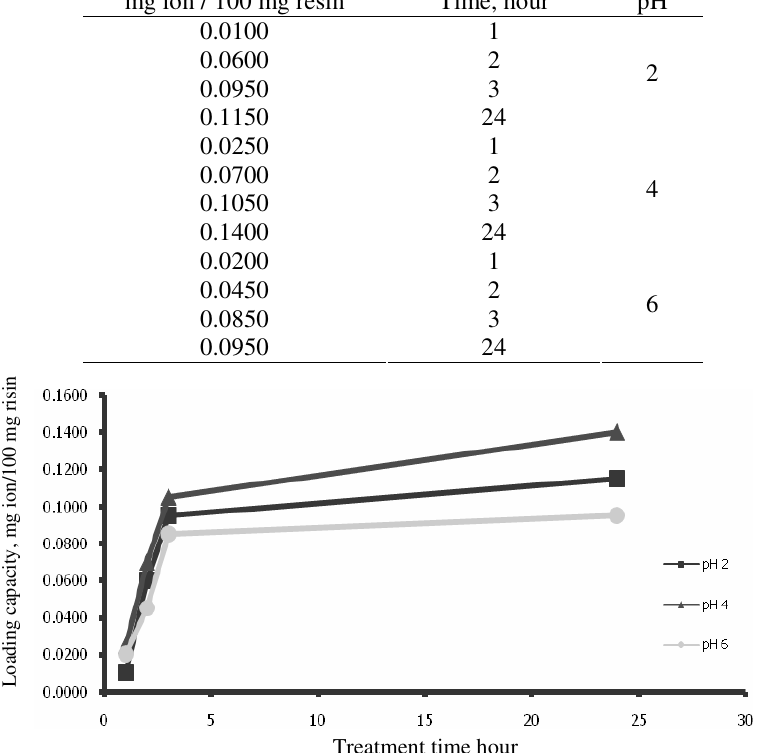
Figure 4. The effect of treatment time of the loading capacity for Ni(II) ion in different